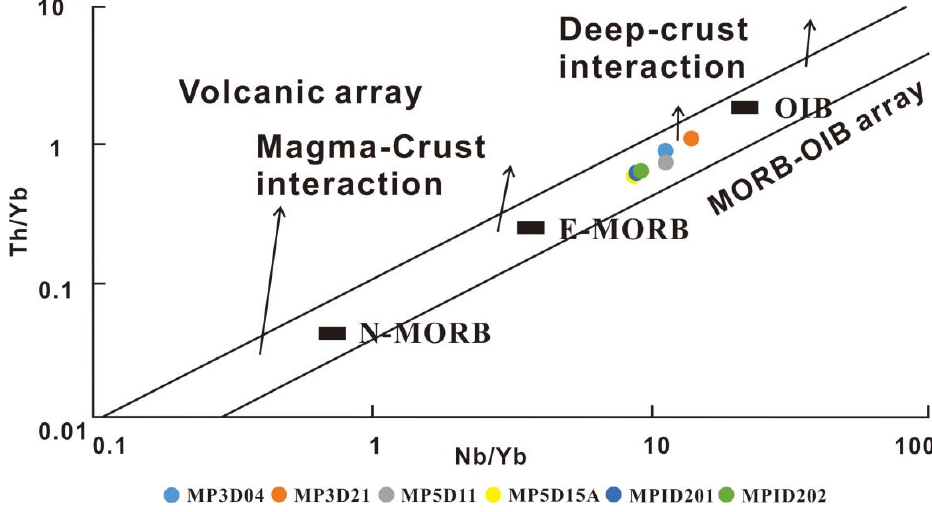
Figure 7. Nb/Yb–Th/Yb discrimination diagram of seamount basalt in the Western Pacific (after Pearce, J.A., 2007 [44]).